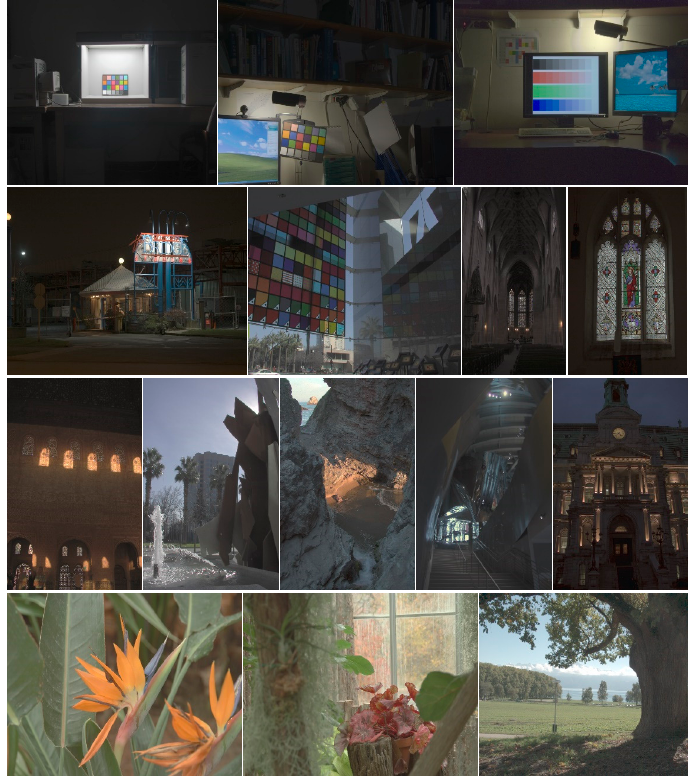
Figure 8. Thumbnails of test images.